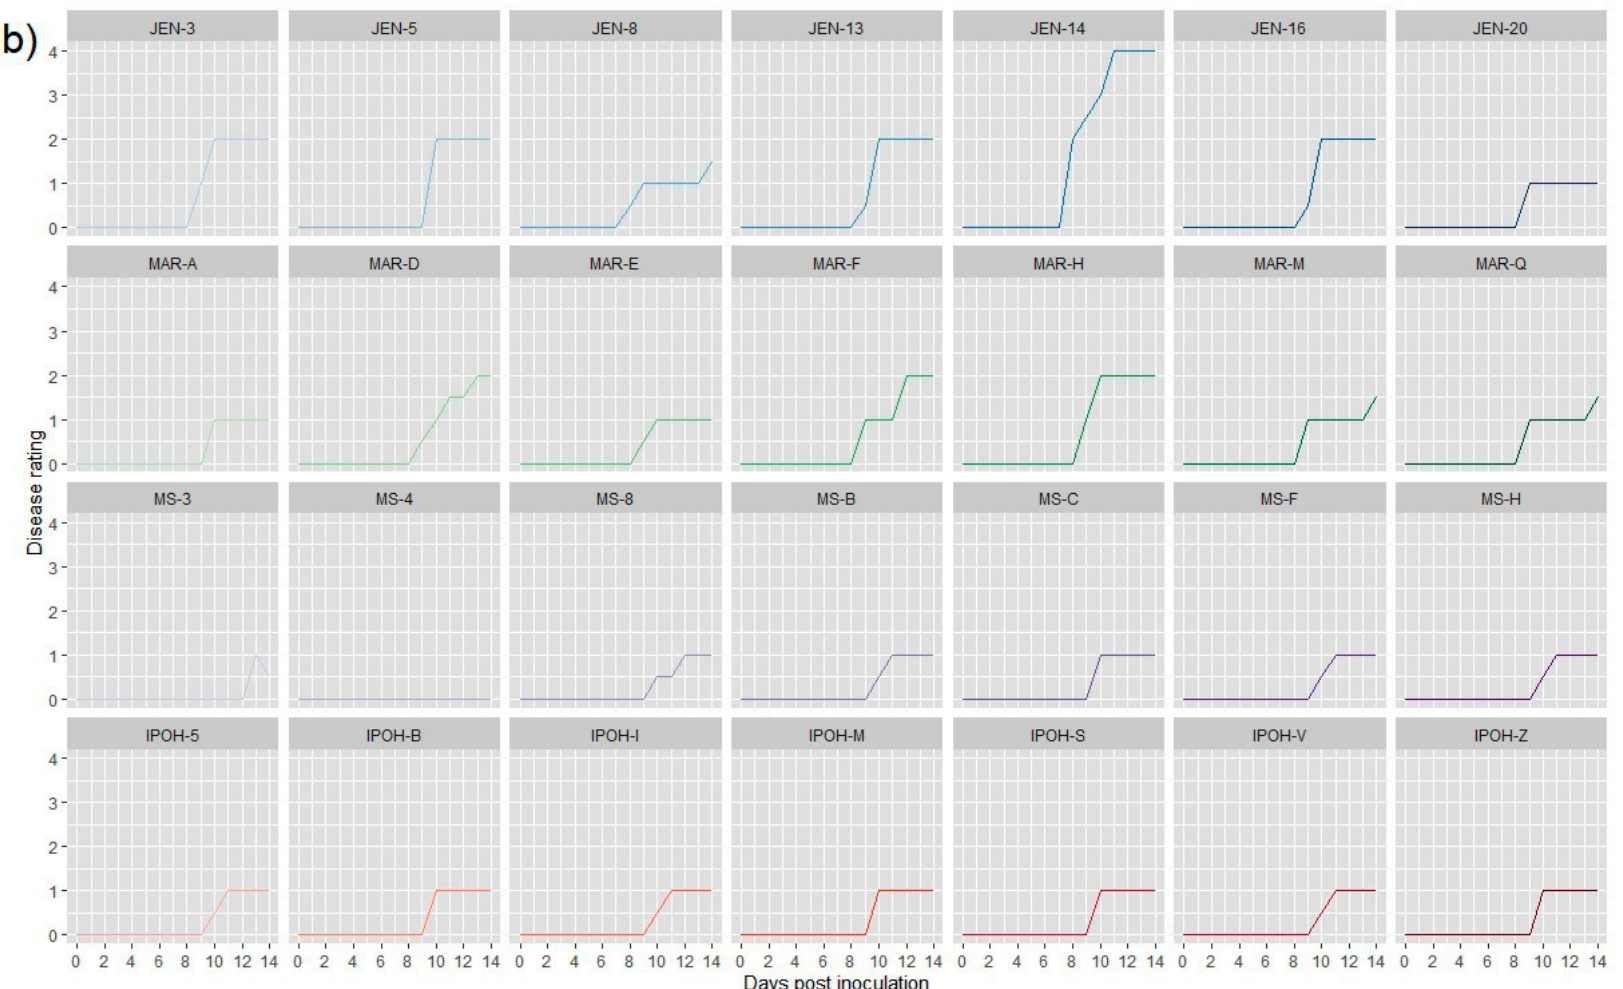
Figure 8. The median disease rating progression (0–4) of Pantoea stewartii subspecies stewartii ( n = 28) inoculated on ( a ) cucumber ( b ) pineapple, within 14 days post-inoculation. The color ranges and columns are displayed based on collection areas: blue on the Jenderam isolates (column 1); green on the Maran isolates (column 2); purple on the Muadzam Shah isolates (column 3); and red on the Ipoh isolates (column 4).